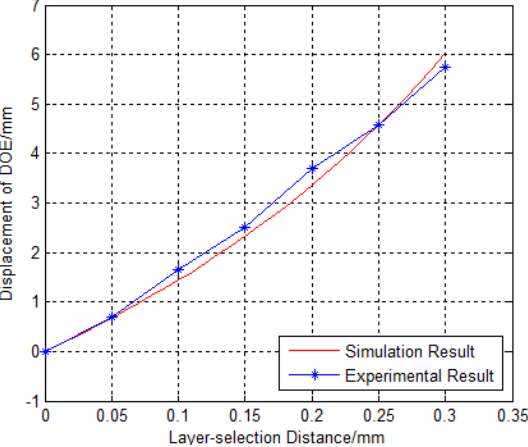
Figure 14. Results of the layer-selection distance versus displacement of